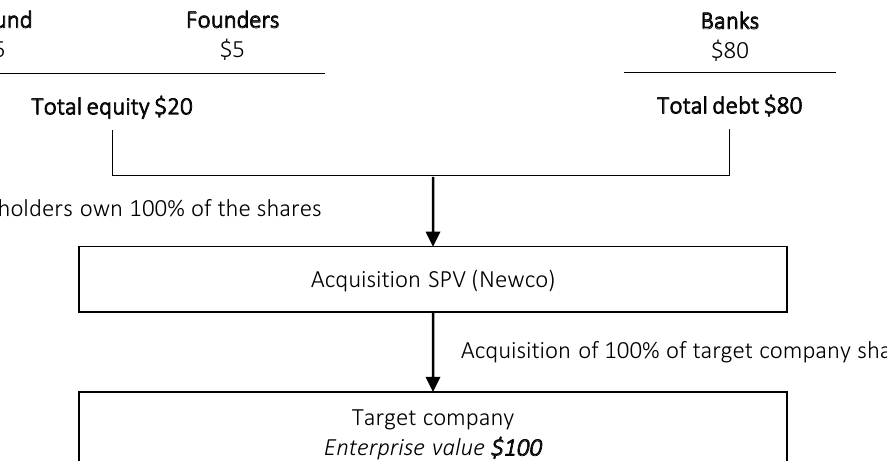
Source: Figure prepared by the